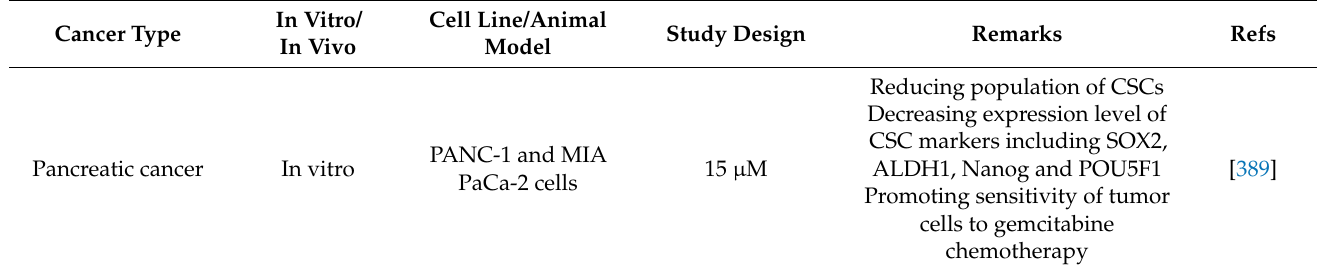
Table 8. The BBR in targeting CSCs for tumor